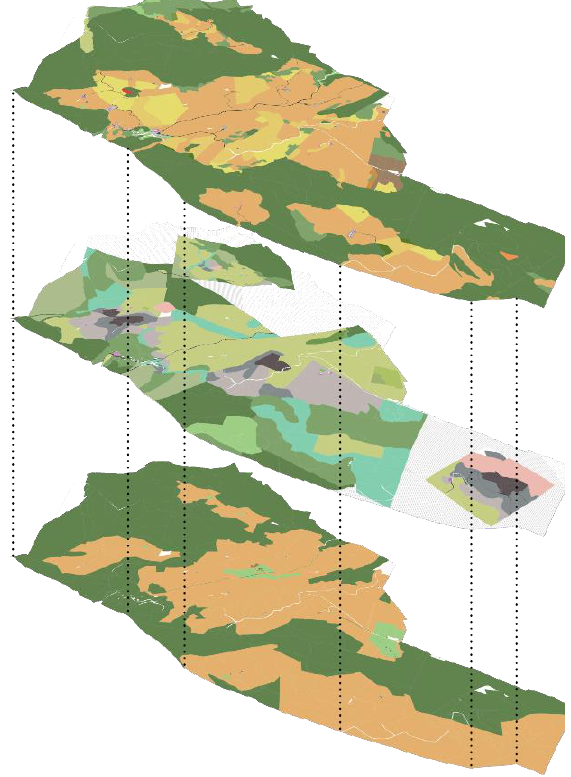
Figure 8 . Overlapping of different LCLU Analysis in the three time frames of study: 1850, wartime, 2015 (bottom to top) and space, which have almost entirely compromised the existence in favor of numerous areas left free, and then to meadow (Fig.9). In the post-war period, however, pasture was